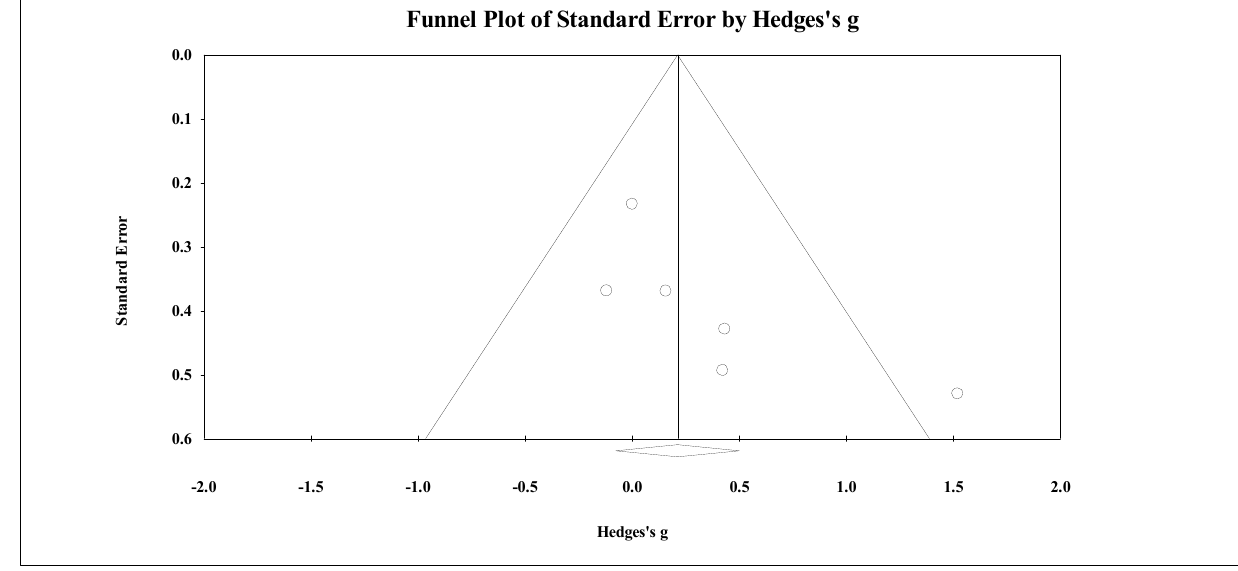
Figure 4. Forest plot of changes in total body bone mineral density in untrained adults after a training program based on soccer small-sided games (SSG) compared to active controls. Values shown are effect sizes (Hedges’s g) with 95% confi- dence intervals (CI). The size of the plotted squares reflects the statistical weight of each study. The black diamond reflects the overall result.